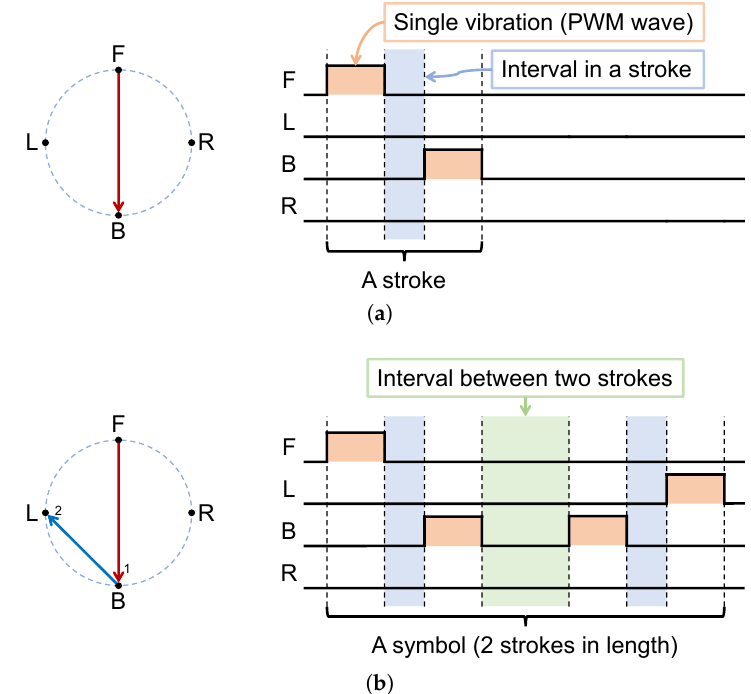
Figure 3. The pattern of motor vibration sequence we used and the corresponding pattern, taking the neck ring as an example. ( a ) Vectorized perception of a pair of stimuli FB and corresponding motor vibration timing diagram. ( b ) Vectorized perception of a complete set of stimuli FBBL and corresponding motor vibration timing diagrams.